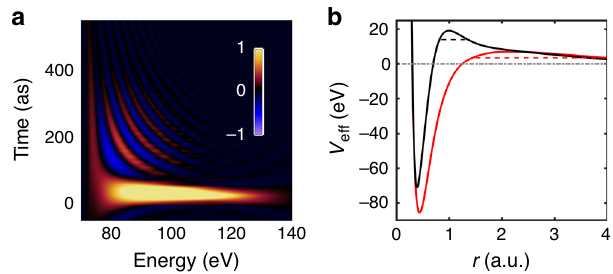
Fig. 5 Wigner representation and effective potentials. a Wigner representation W ( E , t ) for the 4 d 5/2 → ϵ f 5/2 channel. The amplitude is indicated by the color code on the right. b Illustration of one-electron potentials for the 1 S → 3 P , 3 D transitions (red) and 1 S → 1 P (black). Dashed lines suggest possible electron trajectories in the two cases.